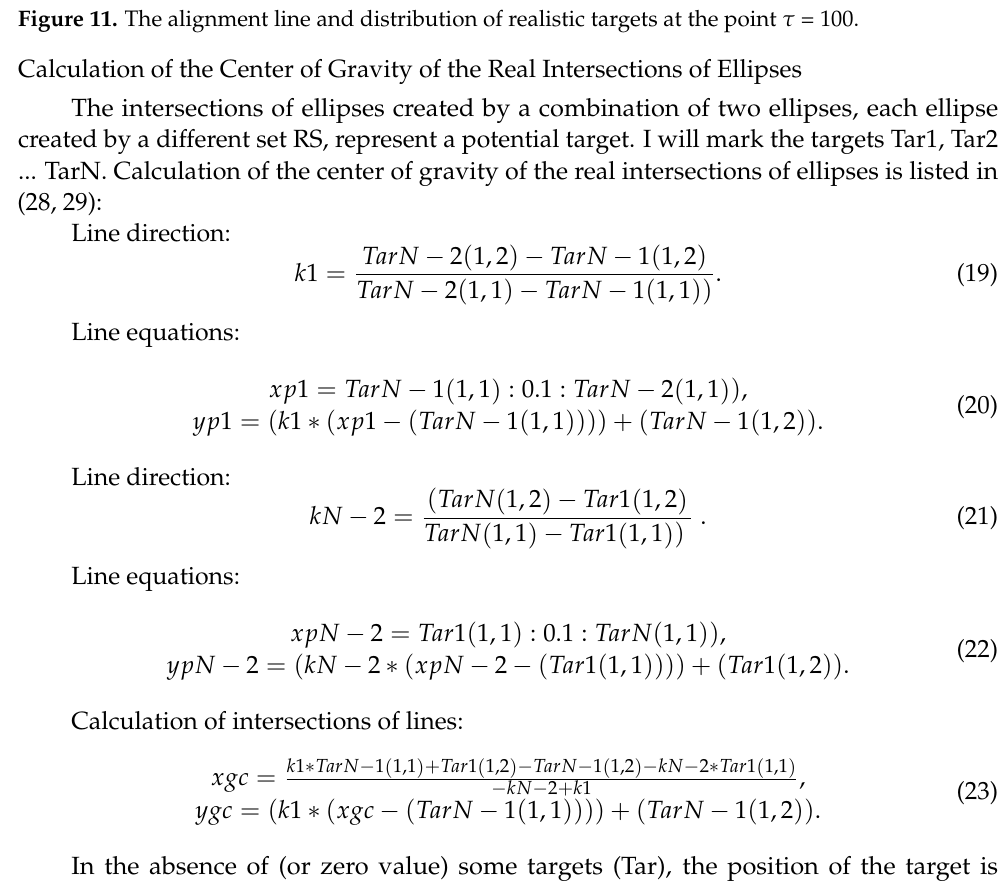
Figure 11. The alignment line and distribution of realistic targets at the point τ = 100.